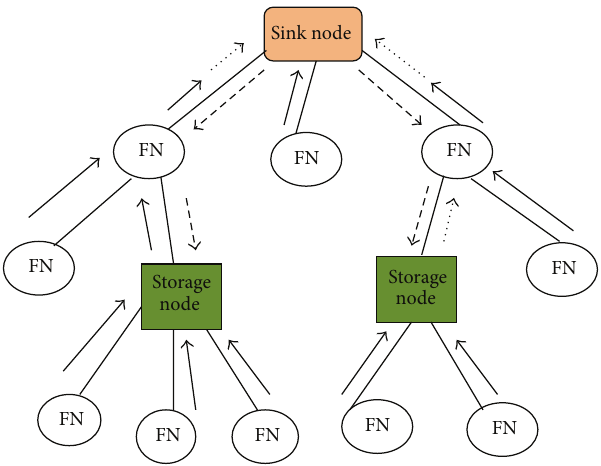
Figure 2: An example of data storage in wireless sensor networks.